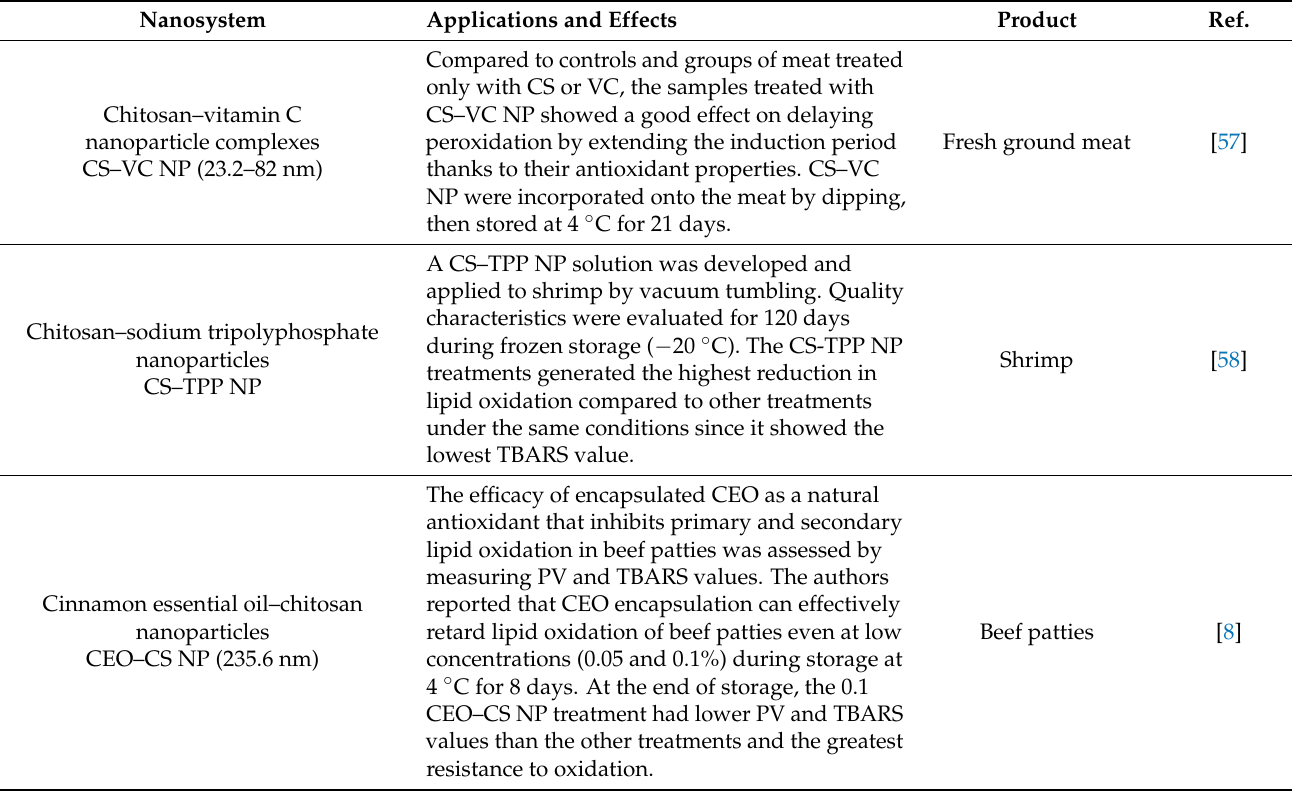
Table 3. Summary of nanosystems applied on meat and meat products and their antioxidant effect.